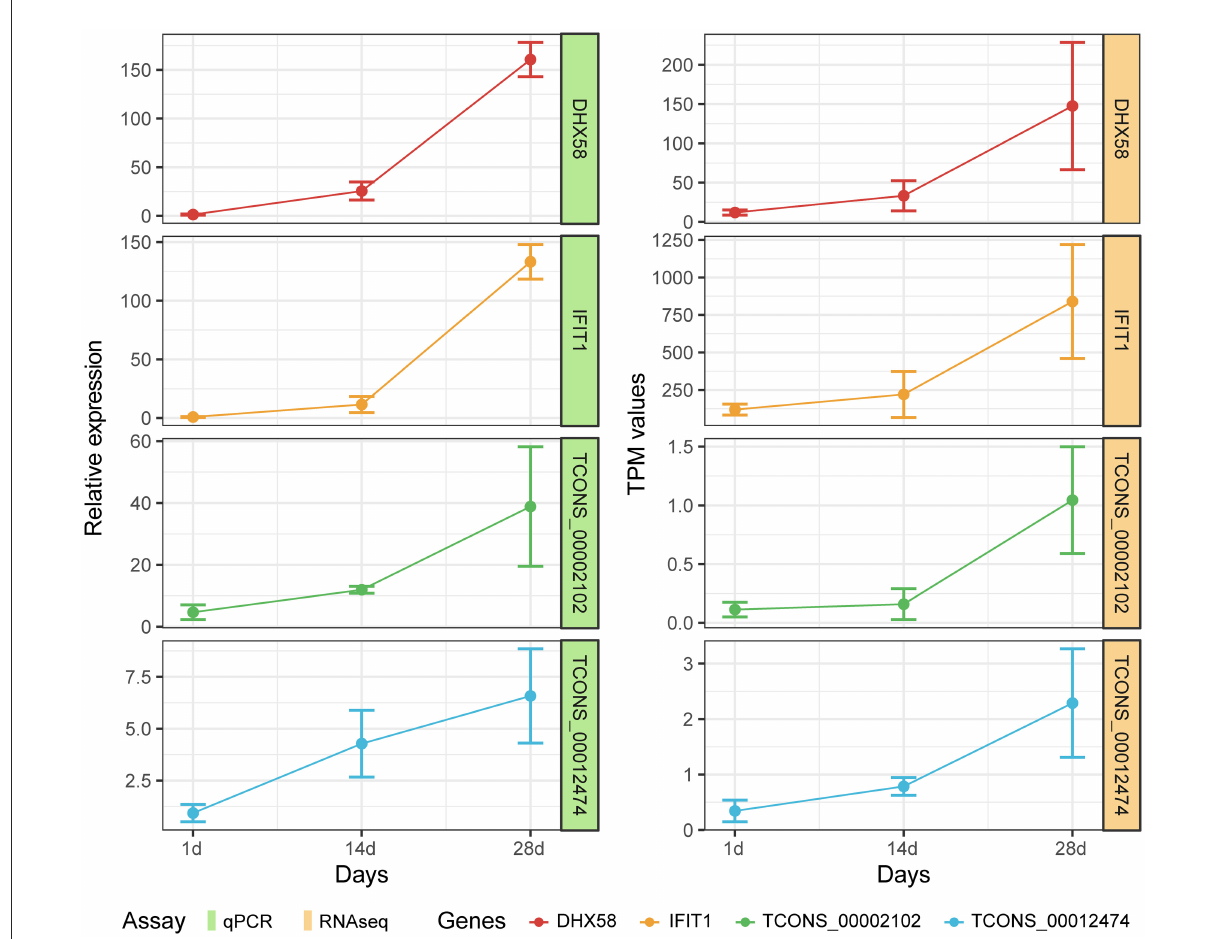
FIGURE7 Expression patterns of DHX58, IFIT1, TCONS-00002102, and TCONS-00012474 compared with expression patterns obtained by